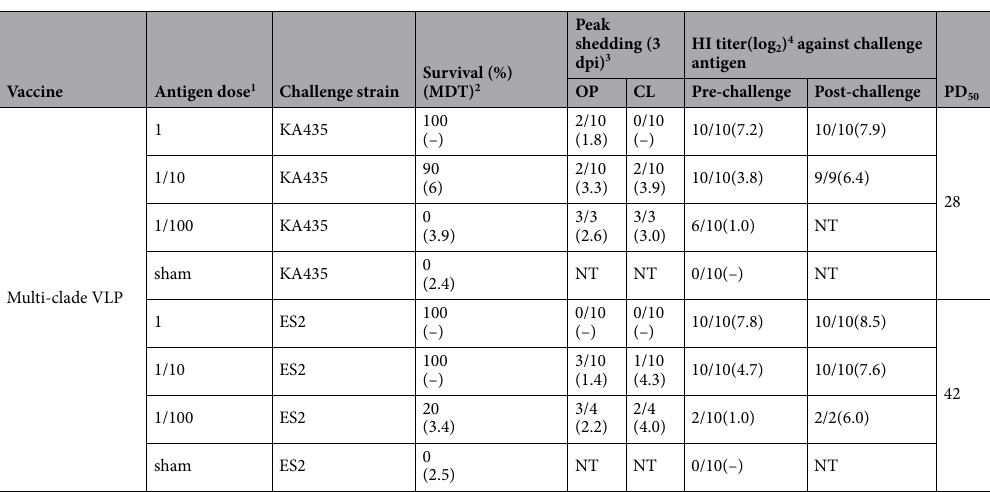
Vaccine Antigen dose 1 Challenge strain